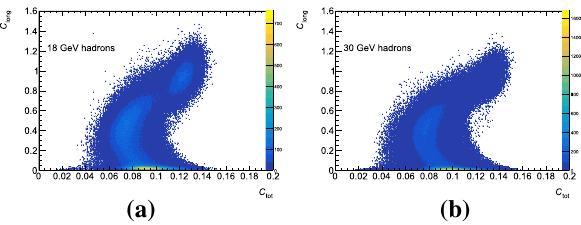
Fig. 7 Scatter plot C long vs C tot of e /π sample events produced by beams of particles with energies equal to 18 GeV ( a ) and 30 GeV ( b ). The color scale indicates the number of events in the